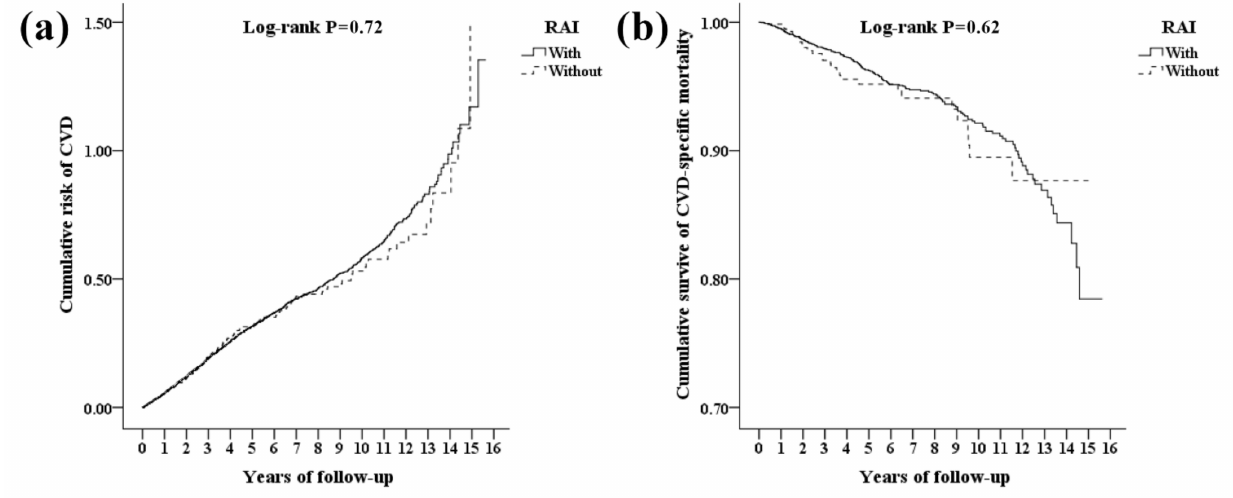
Figure 2. Kaplan–Meier plots for the cumulative risk of cardiovascular diseases (CVD) ( a ) and cumulative survival of CVD-specific mortality stratified by radioiodine (RAI) with log-rank test ( b